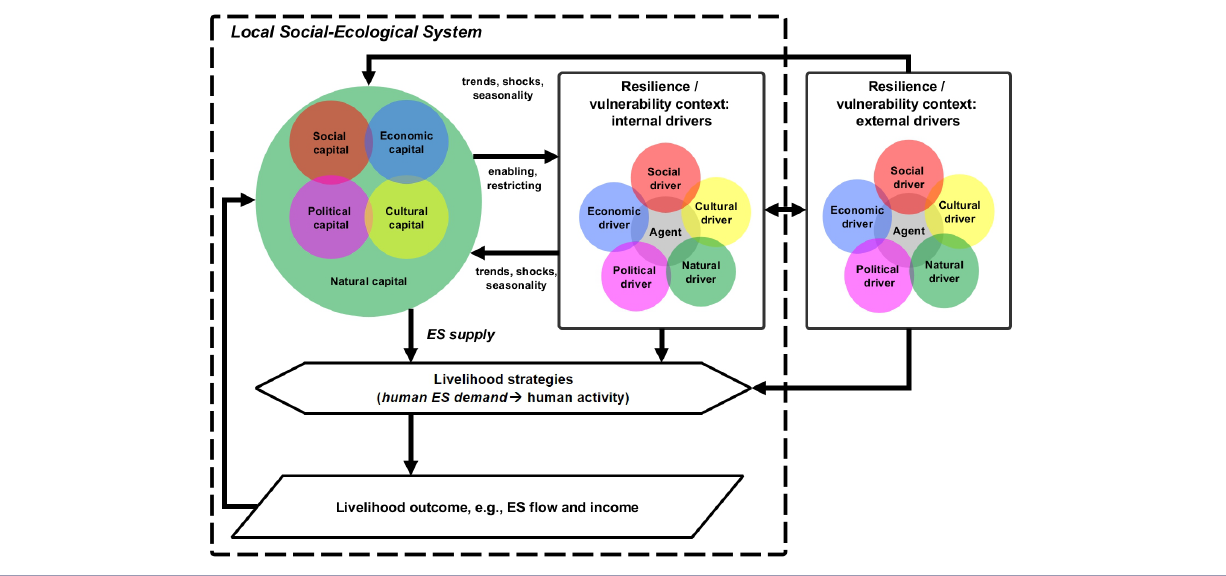
Fig. 1 . Resilient livelihood framework (RLF) to evaluate the resilience of social- ecological systems by combining sustainable rural livelihoods and ecosystem service (ES)